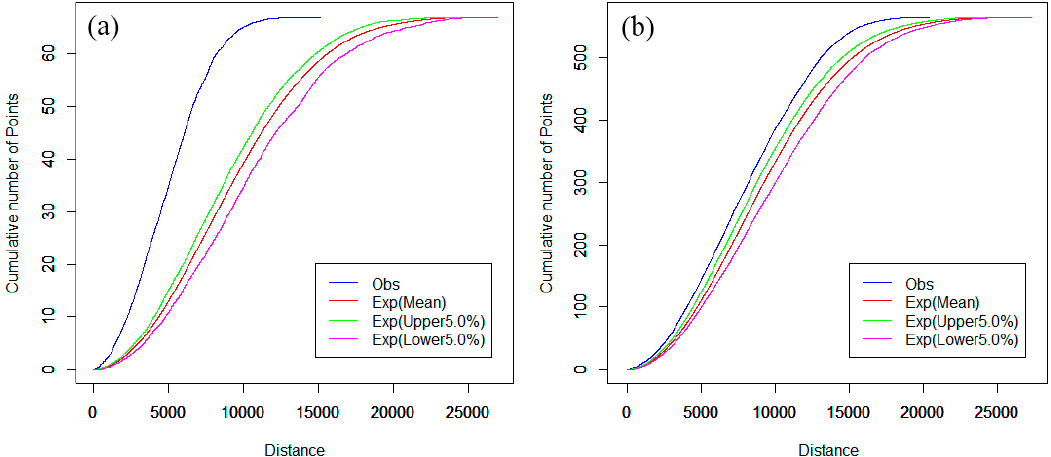
Figure 5. ( a ) Network auto K-function analysis of first- and second-class hospitals and ( b ) network auto K-function analysis of other hospitals in main urban districts.